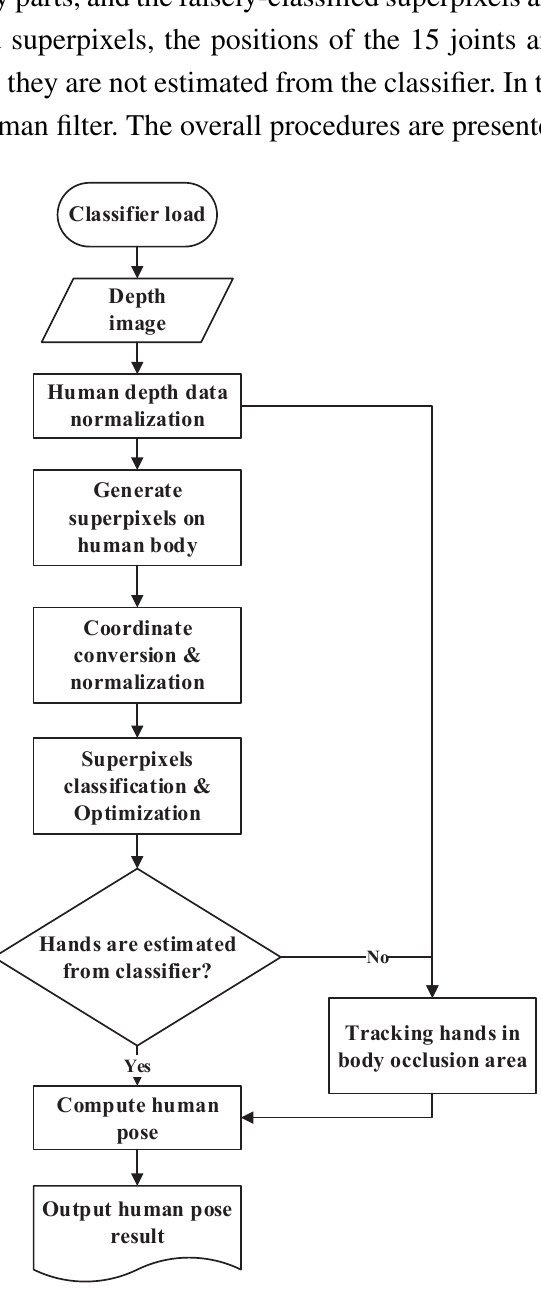
Figure 1. Flow diagram of the proposed human pose estimation